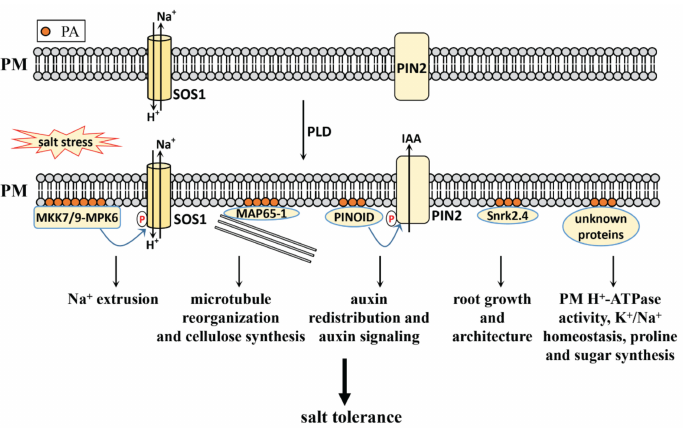
Figure 1. The regulatory role of PLD-derived PA in the salt stress response of plants. PA level is induced by salt stress. PLD α 1-derived PA binds and activates MPK6, MKK7, and MKK9 to phosphorylate SOS1 and activate its activity in extruding excess Na + out of the cells under salt stress; PLD α 1-derived PA can bind MAP65-1 and regulate it activity in microbutule polymerization and bundling process under salt stress, and this process may regulate cellulose synthesis in salt stress; PLD α -1- and PLD δ -derived PA also binds PINOID and stimulates its activity in phosphorylating PIN2 to participate in salt stress response through the regulation of auxin signaling; PA regulates root growth and architecture through the interaction of Snrk2.4; PA also regulates PM H + -ATPase activity, K + -Na + homeostasis, proline and sugar synthesis through the unidentified proteins. PM, plasma membrane; PA, phosphatidic acid; SOS1, salt overly sensitive 1; PIN2, PIN-FORMED 2; MPK, mitogen-activated protein kinase; MKK, mitogen-activated protein kinase kinase; MAP65-1, microtubule-associated protein 65-1; SnRK2.4, SNF1-related protein kinase